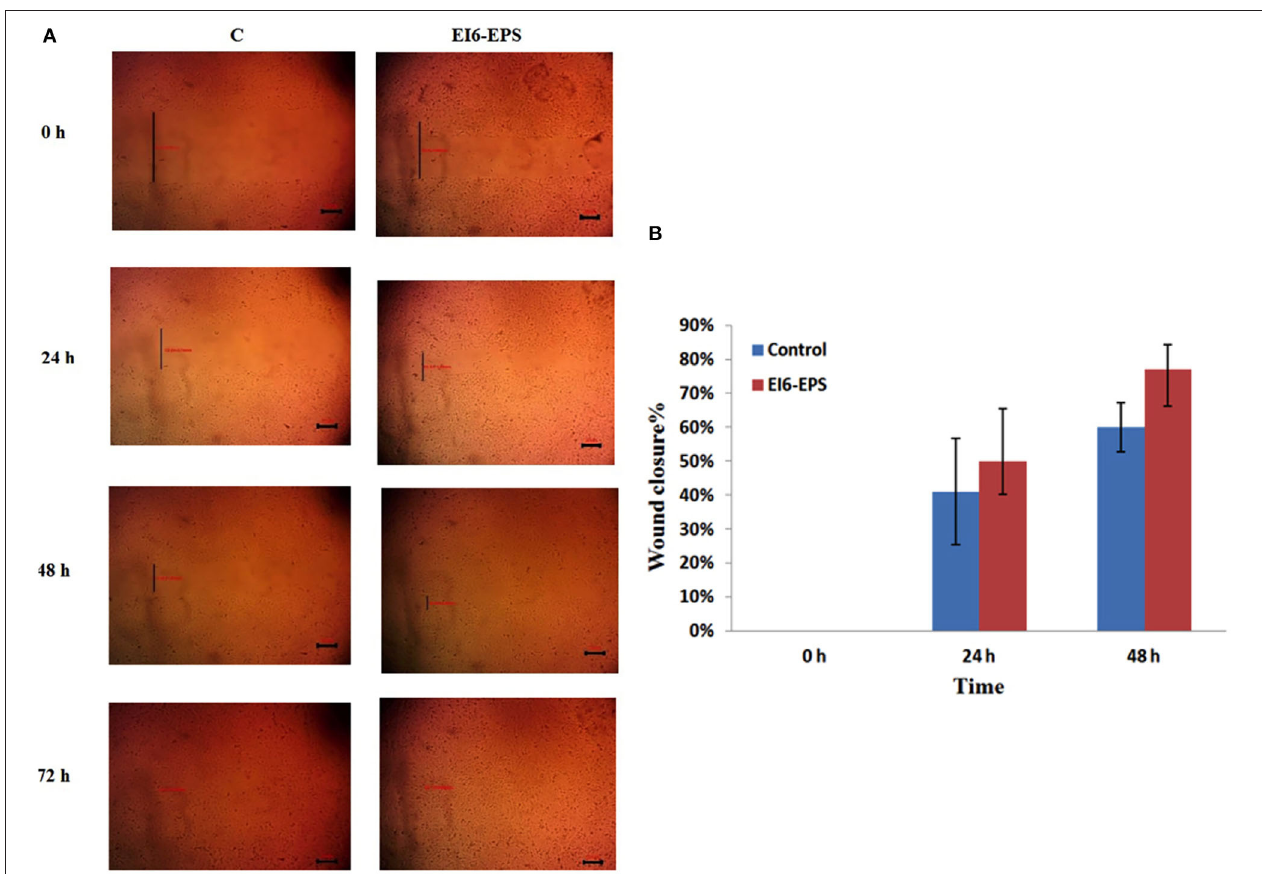
FIGURE 5 | In vitro cell migration of skin fibroblasts by EI6-EPS scratch was created in monolayer of HSF cells and was treated with EI6-EPS. Control group was without any treatment. (A) Photographs of wound area treated with EI6-EPS at different time intervals were taken using an inverted microscope. (B) Percentage wound closure in control and treated cells at different time